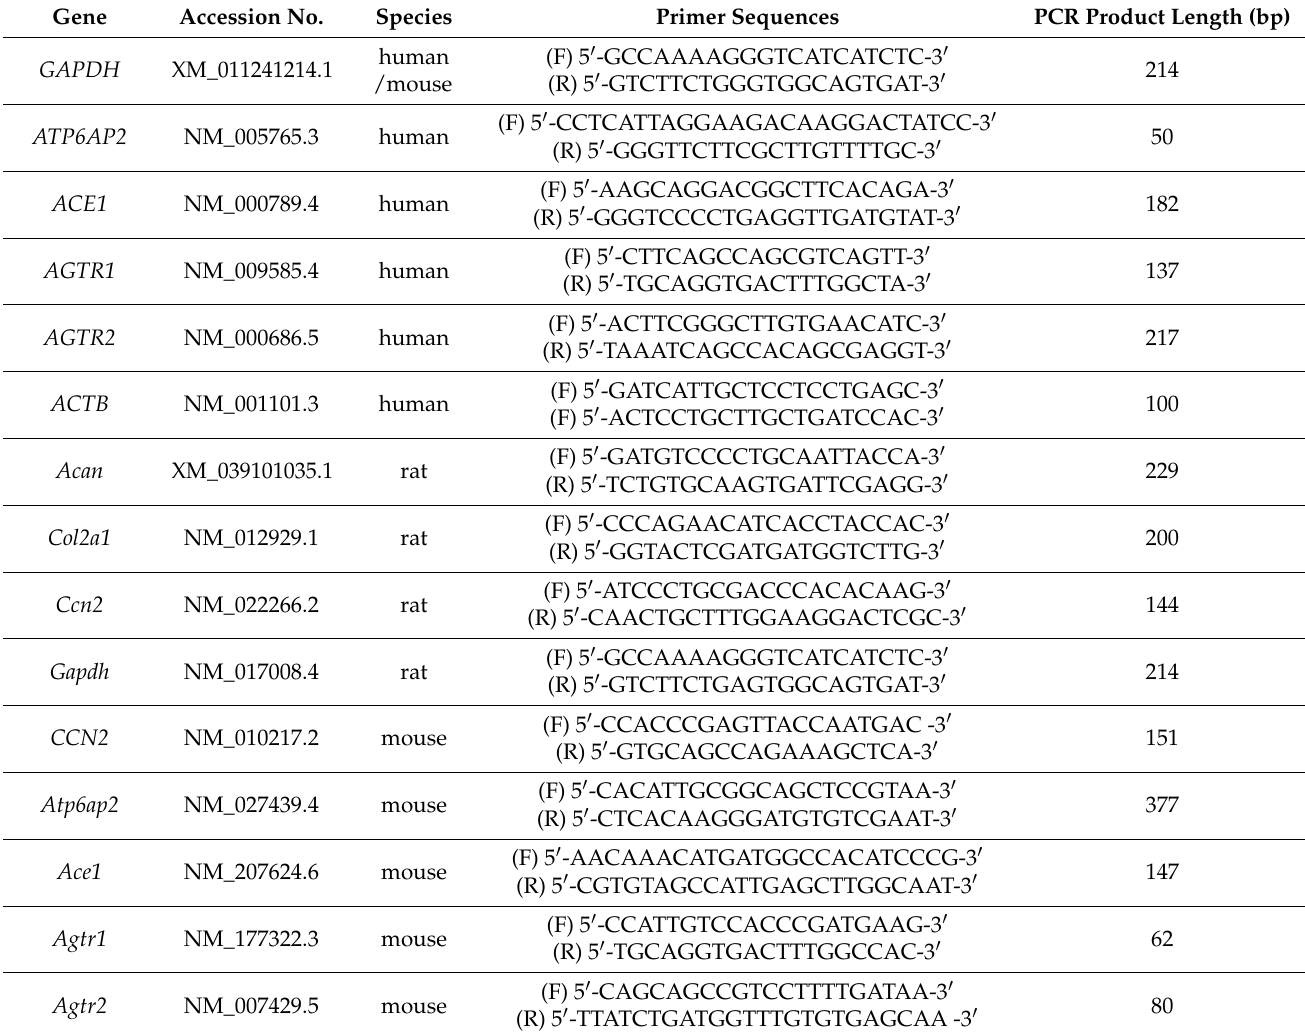
Table 2. Sequences of forward (F) and reverse (R) primers used for quantitative